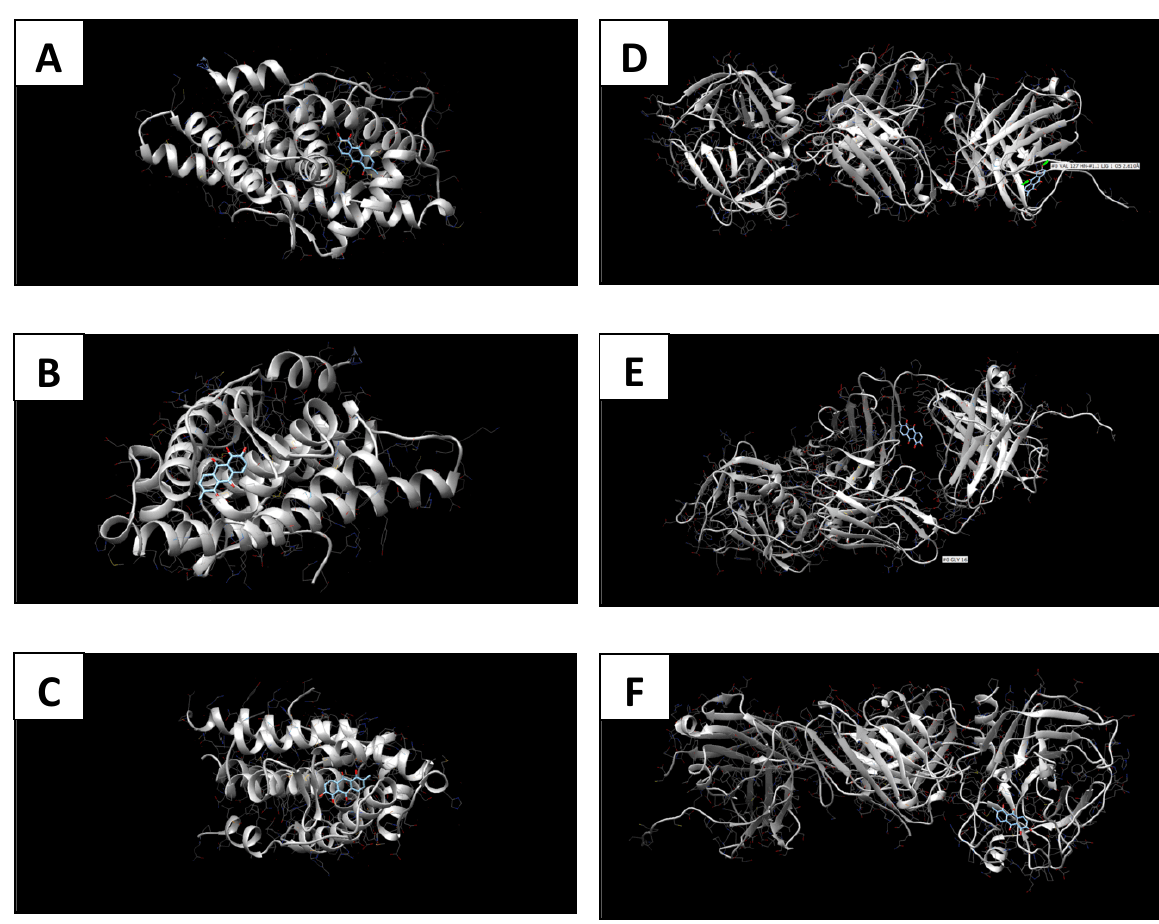
Figure 4. Molecular docking of morindone with androgen receptor (AR) PDB codes: 3RLJ (A), 5T8J (B), 5VO4 (C), and protein specific antigen (PSA) PDB codes: 2ZCH (D), 2ZCK (E), 2ZCL